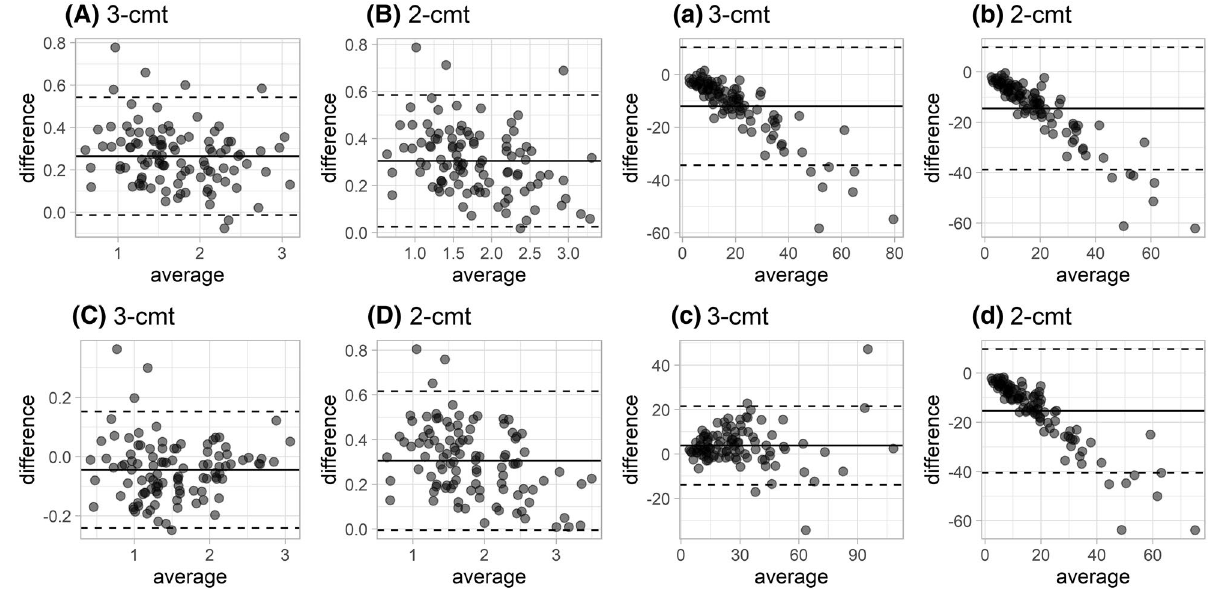
Figure 1. Bland–Altman plots comparing clearance estimates obtained without versus with iohexol concentrations observed 1440 min post injection ( A , B , C , D ) as well as predicted versus observed concentrations 1440 min post injection ( a , b , c , d ) based on empirical Bayes estimates given concentrations ≤ 5-h post injection. Random effects for all pharmacokinetic parameters of three (3-cmt; A and a ) and two (2-cmt;